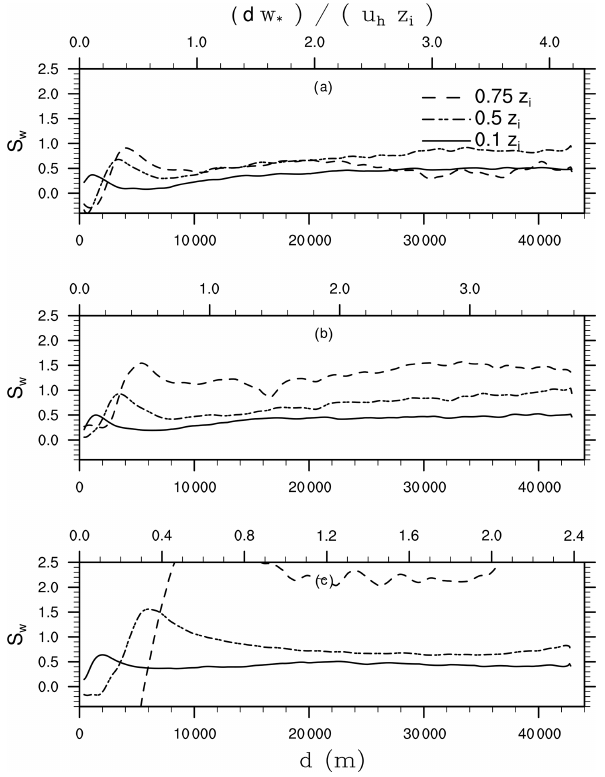
Figure 15. Horizontal profiles of 30min time-averaged skewness S w of w depending on the distance to the inflow boundary. S w is shown for the lower, middle, and upper parts of the boundary layer at (a) 10:00UTC, (b) 13:00UTC, and (c) 16:00UTC. The lower ab- scissa indicates the absolute distance to the inflow boundary, while the upper abscissa indicates the travel time of an imposed signal normalized with the eddy-turnover time. S w is averaged over simi- lar distances to the inflow boundary. Table 4. Scaling parameters at 13:00UTC for the sensitivity simu- lations.